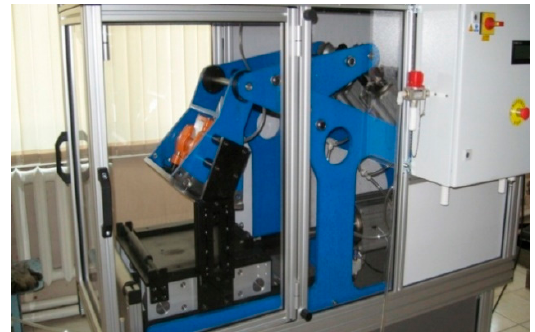
Figure 5. Sector compactor.